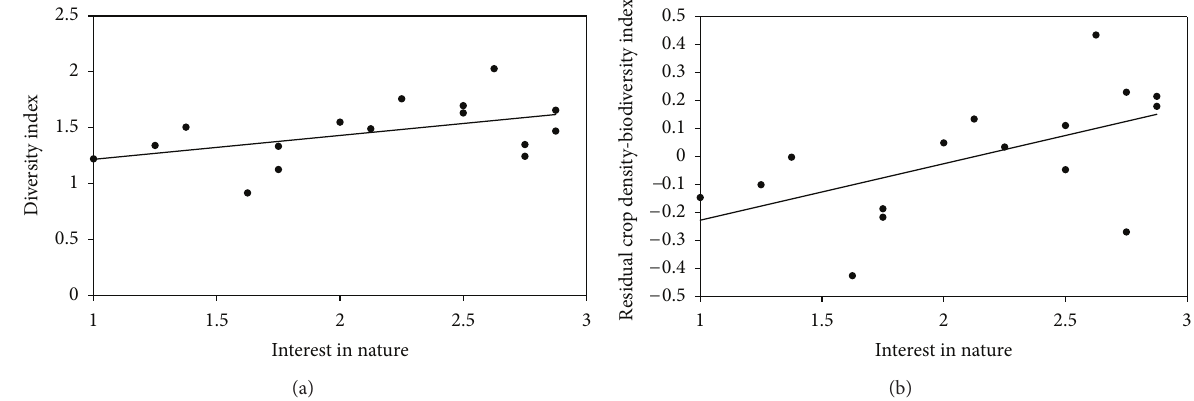
Figure 2: Relationships (with regression lines) between (a) the biodiversity index and farmers interest in nature and (b) the residual of crop density and biodiversity index and farmers interest in nature. Statistics: (a) 𝑅 2 = 0.233 , 𝑃 = 0.0581 , (b) 𝑅 2 = 0.315 , 𝑃 = 0.0237 ).